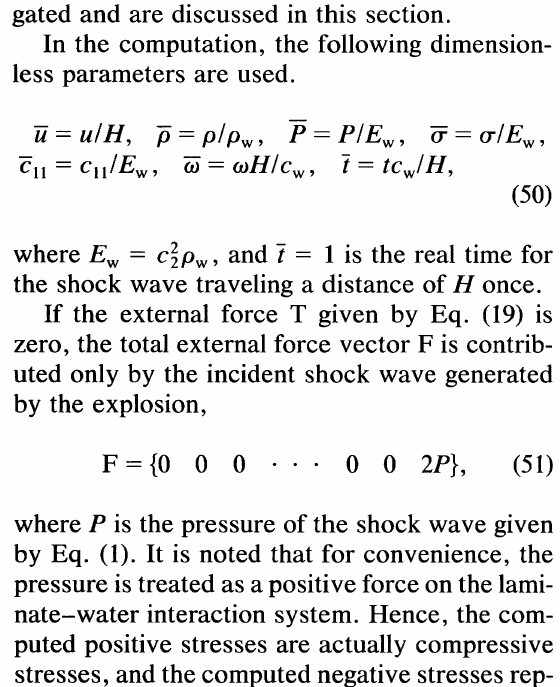
Table 1. Dimensions and Material Parameters for Steel Plate and Sandwich Laminate